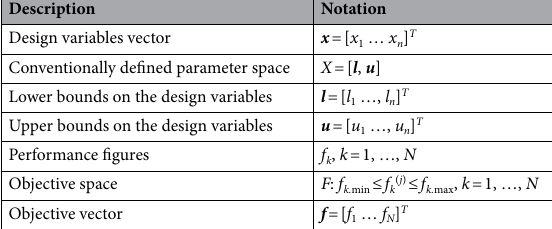
Table 1 gathers the basic objects utilized in constrained modeling 48 : the design variable vector x (typically geometry parameters of the device under study), as well as the two spaces of interest: the parameter space X , and the objective space F . The entries of the design objective vector F may include, e.g., antenna operating fre- quency/frequencies or bandwidth/bandwidths, but also substrate permittivity the structure is implemented on. The region of validity of the surrogate is supposed to cover the objective space F , delimited by the user-specified ranges of performance figures. In constrained modeling, the surrogate model domain is to encompass the designs optimal with respect to the assumed figures of merit. The optimal design is understood here as minimizing the scalar objective function U ( x , f ) that quantifies the design quality 52